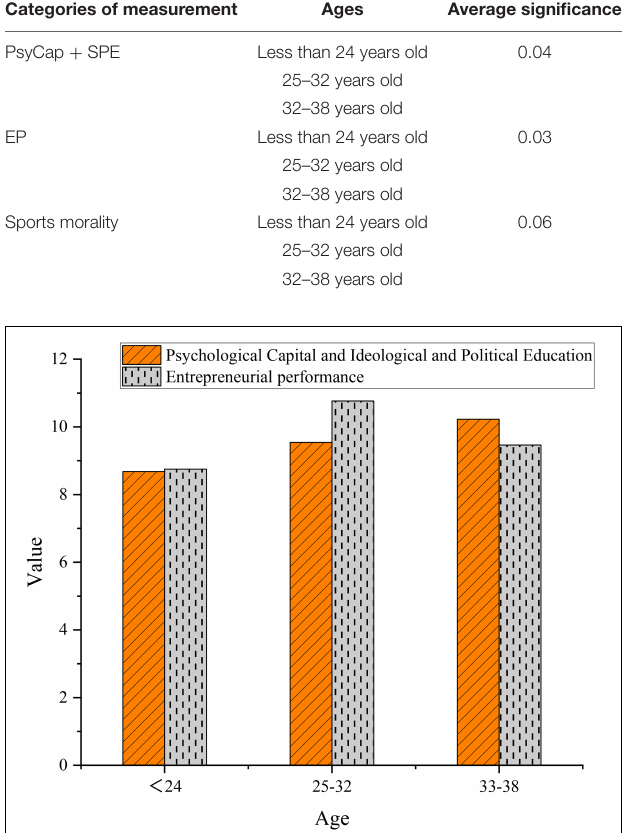
FIGURE 5 | Average scores of college entrepreneurs of different